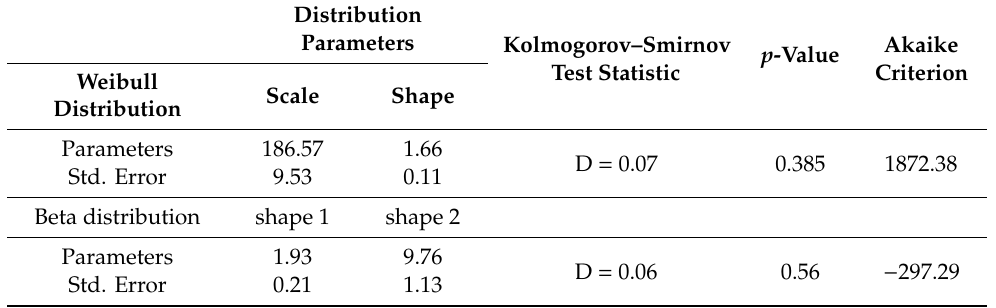
Table 2. Estimated model parameters according to Weibull and Beta